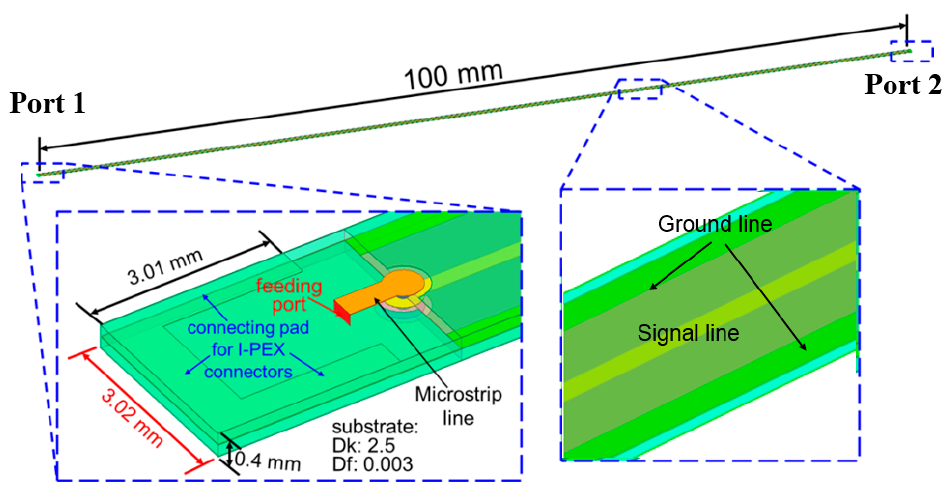
Figure 4. Preliminary simulation setup for full-wave EM simulation software.